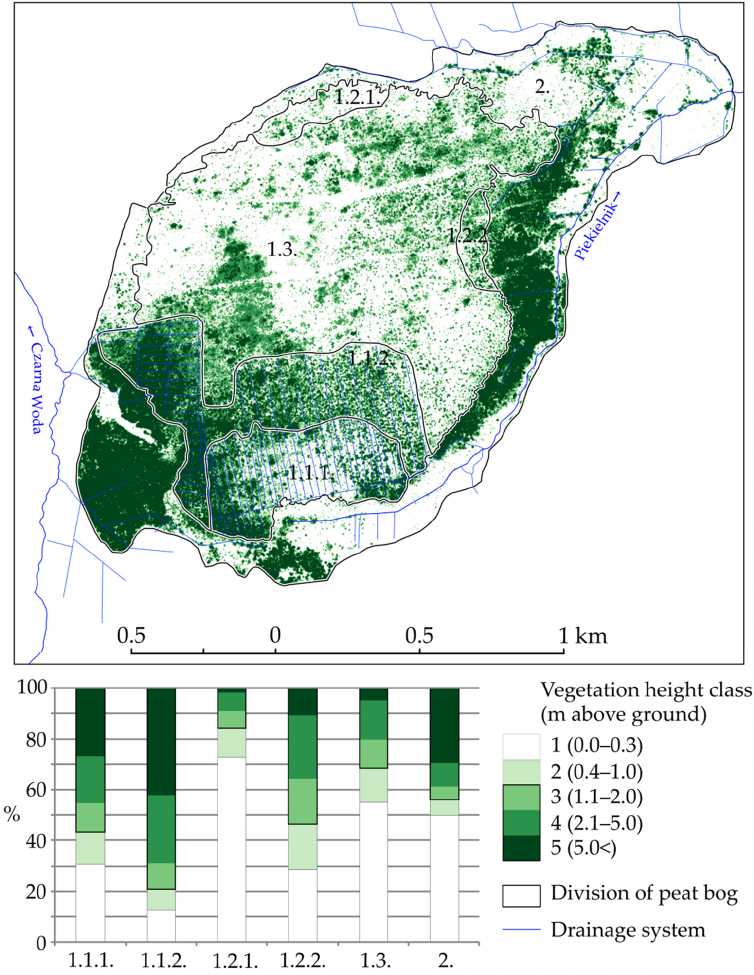
Figure 5. Distribution of vegetation height classes in the Baligówka peat bog. The entering of medium and high vegetation into the peat bog area is related spa- tially to the drainage network (Figure 6). The areas it occupies (Figure 6a) are negatively correlated ( ρ = − 0.615) with the distance to the drainage system (Figure 6b).